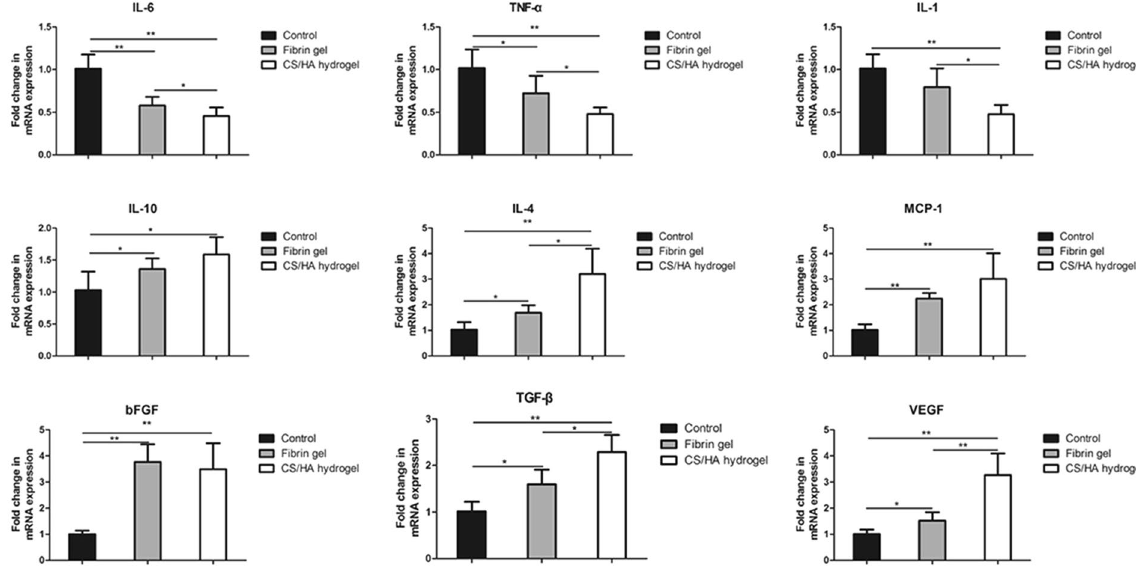
Figure 8. Quantitative analysis of gene expression in three groups. Relative expression of cytokines involved in tissue regeneration were expressed as fold change. Data are presented as mean with standard deviation as error bars, * P < 0.05, ** P <